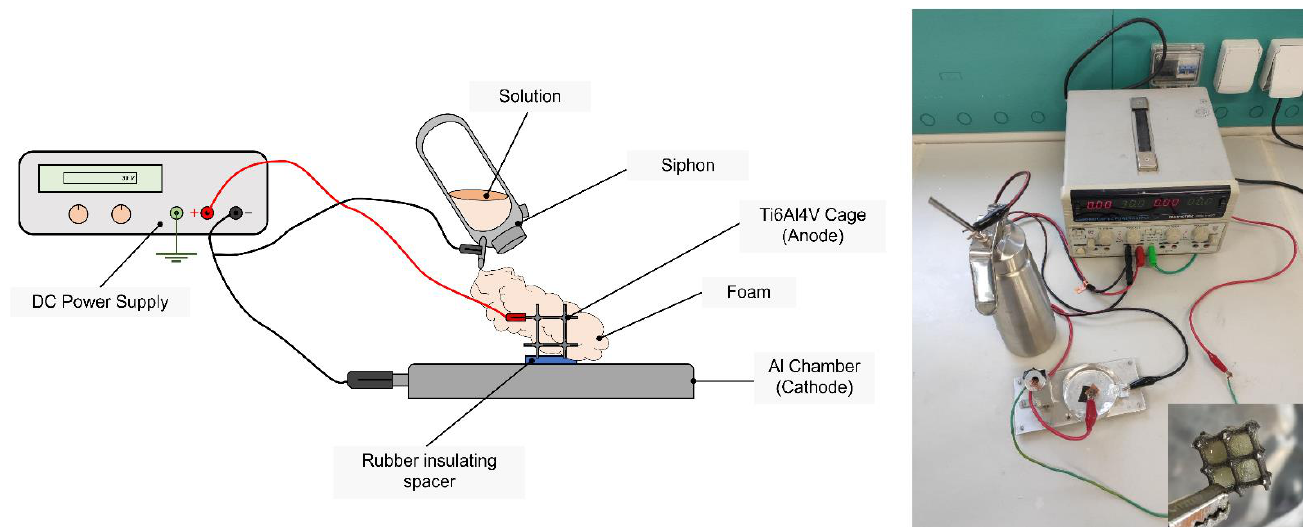
Figure 2. An illustration and image of the electrowetting setup, composed of a DC power supply, a siphon, a counter-electrode chamber in aluminum, and the Ti6Al4V cage, acting as the anode of the electrophoretic chamber. A close-up image of an electrowetted composite system is reported in the lower-right corner of the